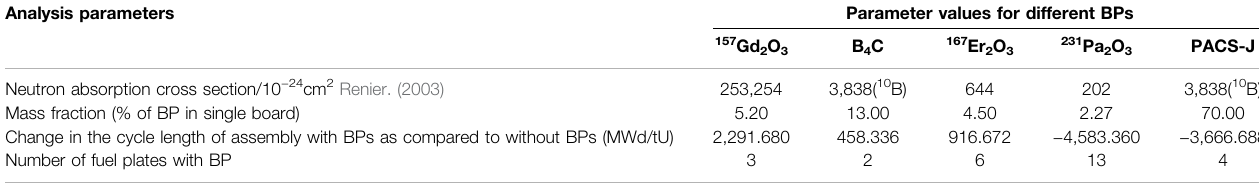
TABLE 3 | Analysis parameters for different BPs.